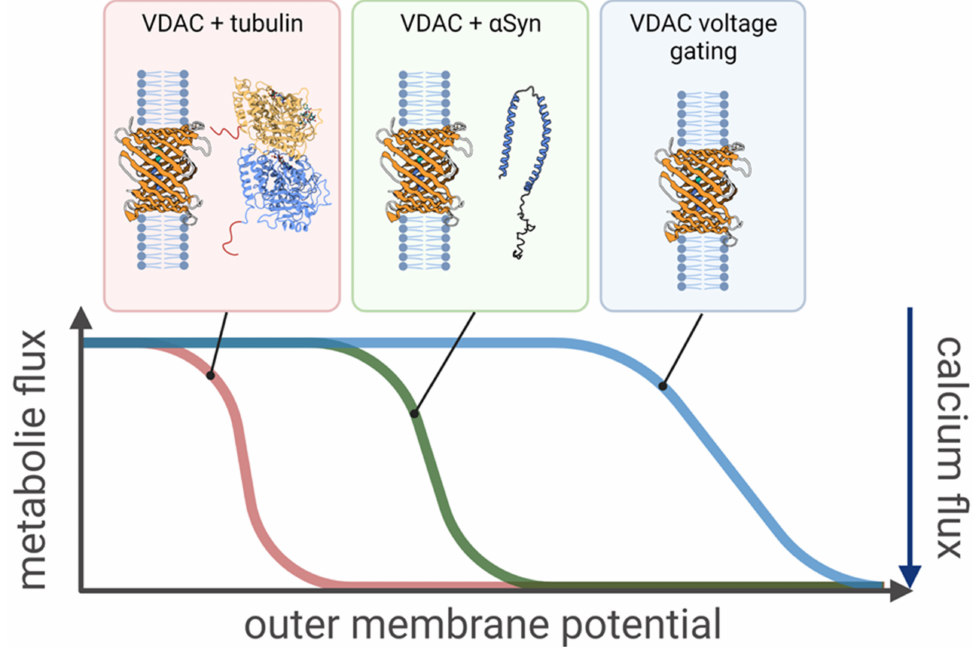
Figure 1. Increased sensitivity of VDAC (PDB ID: 3EMN) regulation to transmembrane potential in the presence of cytosolic regulators. Only a fraction of the outer membrane potential, relative to that necessary to induce channel voltage gating, is required for the effective control of VDAC-induced transport by tubulin and α Syn at concentrations as small as 10 nanomolar. The transport properties of the channel in response to the outer membrane potential, i.e., decrease in metabolite flux and the concomitant increase in calcium flux, remain qualitatively the same in all three cases. The “effective gating charge,” expressed as the steepness of the voltage dependence curve, is lowest for voltage gating (blue curve) and the highest for tubulin (red curve), with α Syn (green curve) in